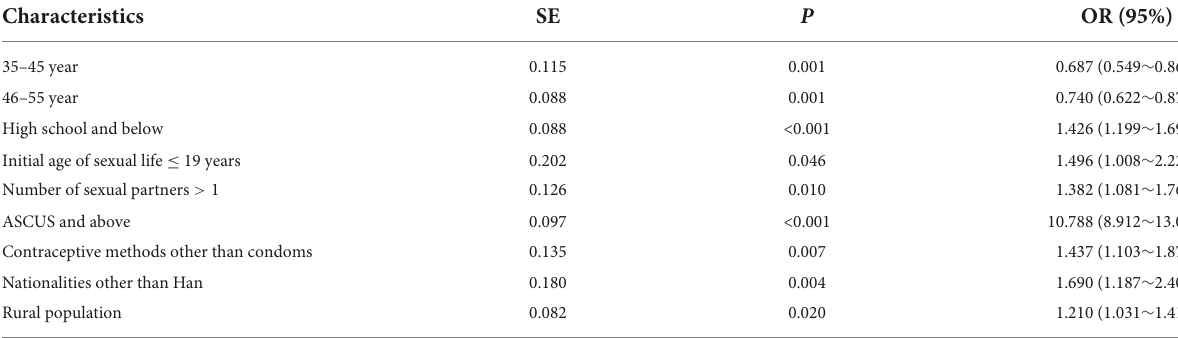
TABLE 12 Multivariate analysis of risk factors affecting human papillomavirus (HPV) infection.